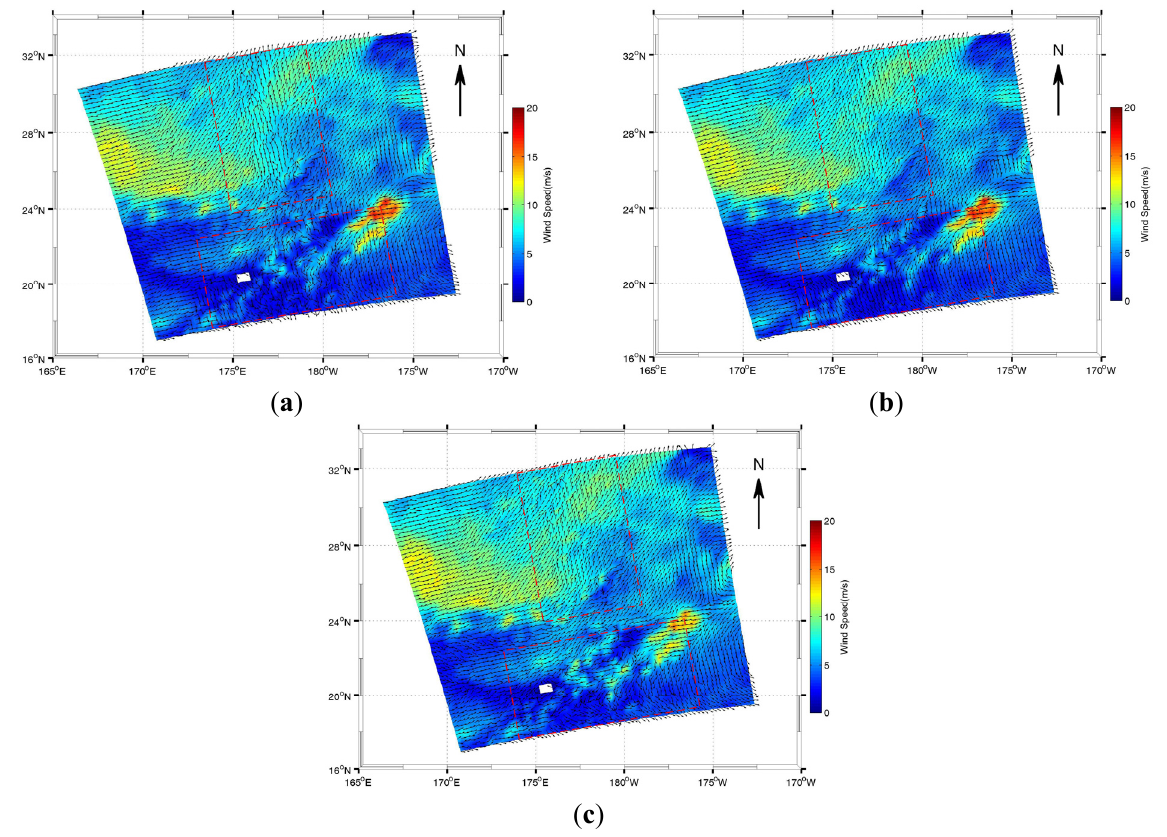
Figure 6. The example wind fields (orbit 10163): ( a ) retrieved by the traditional WSSD algorithm; ( b ) retrieved by the new integrated algorithm; and ( c ) the same wind field from SeaWinds L2B product.